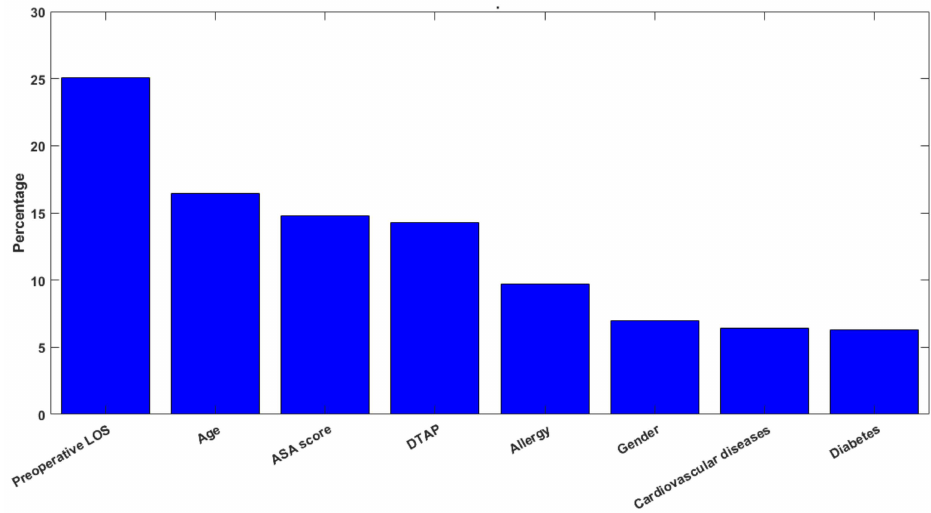
Figure 2. Histogram describing the feature